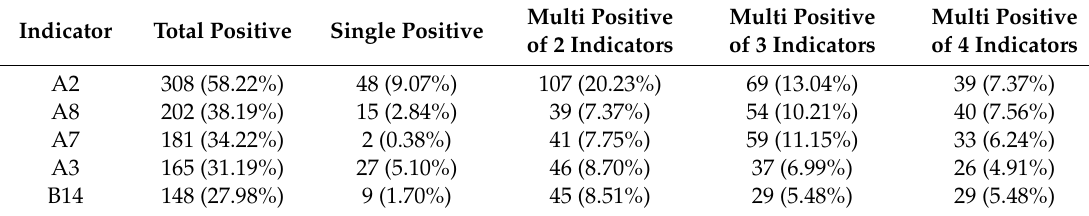
Figure 4. Single positive frequency of indicator B in the sample area. Table 2. Positive frequency of the main indicator.